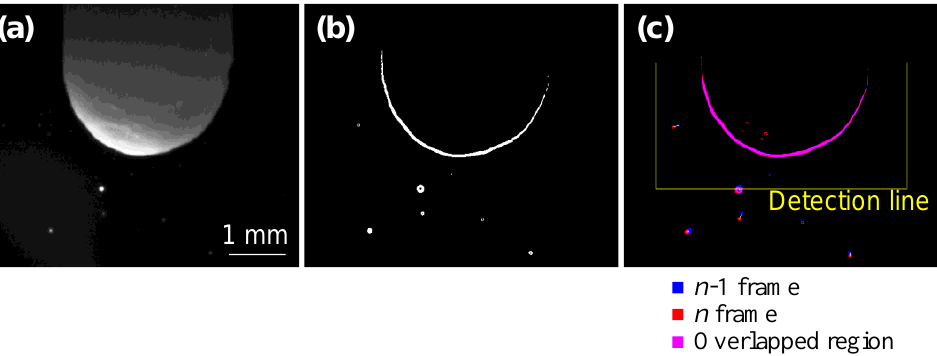
Figure 2. Image processing for the detection of droplet ejections: ( a ) original image of electrode’s appearance; ( b ) edge-detected and binarised image; and ( c ) superimposed image of binarised images for two consecutive frames.